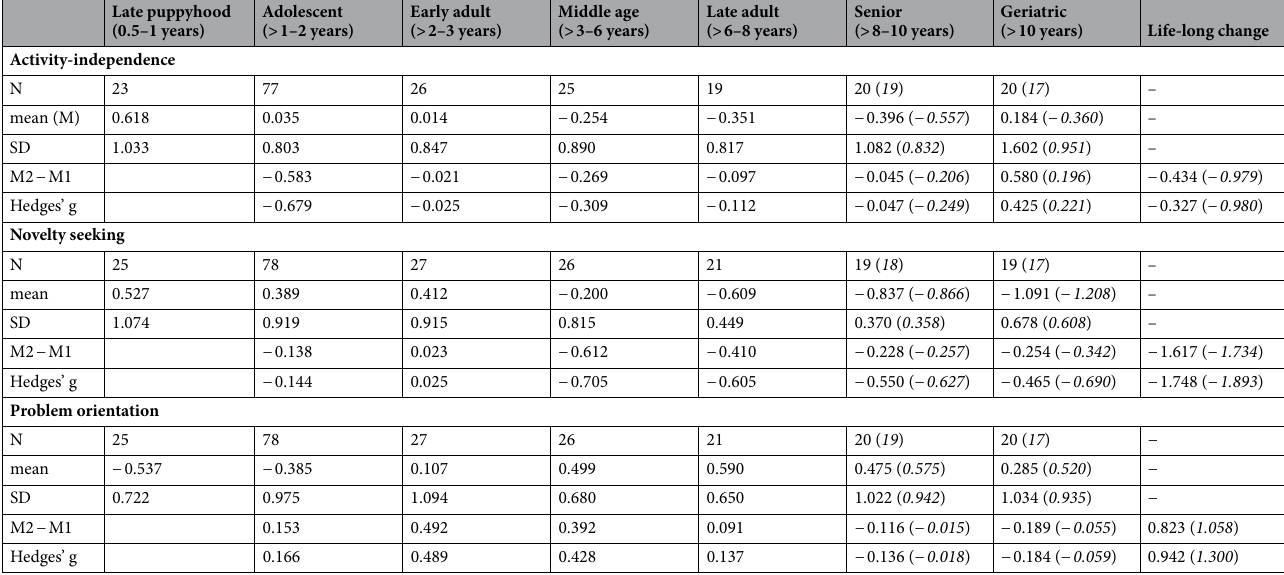
Table 3. Descriptive statistics of the seven age groups in Activity-independence, Novelty seeking, and Problem orientation traits. The mean difference (M2 − M1 = mean of the younger group subtracted from the mean of the older group), and standardised mean difference (Hedges’ g) is calculated from each age group to the next, as well as from late puppyhood to geriatric age (life-long change). In the senior, geriatric, and the life-long change columns, the numbers in brackets represent the values after excluding the four outlier dogs.